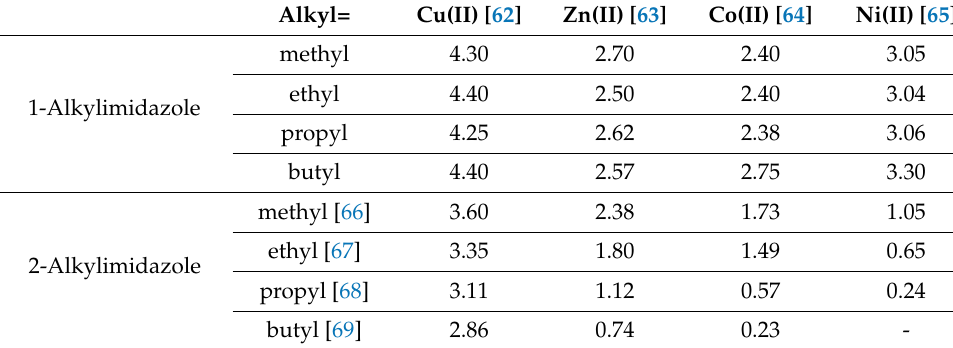
Given values, the stability constants carry 5% tolerance.